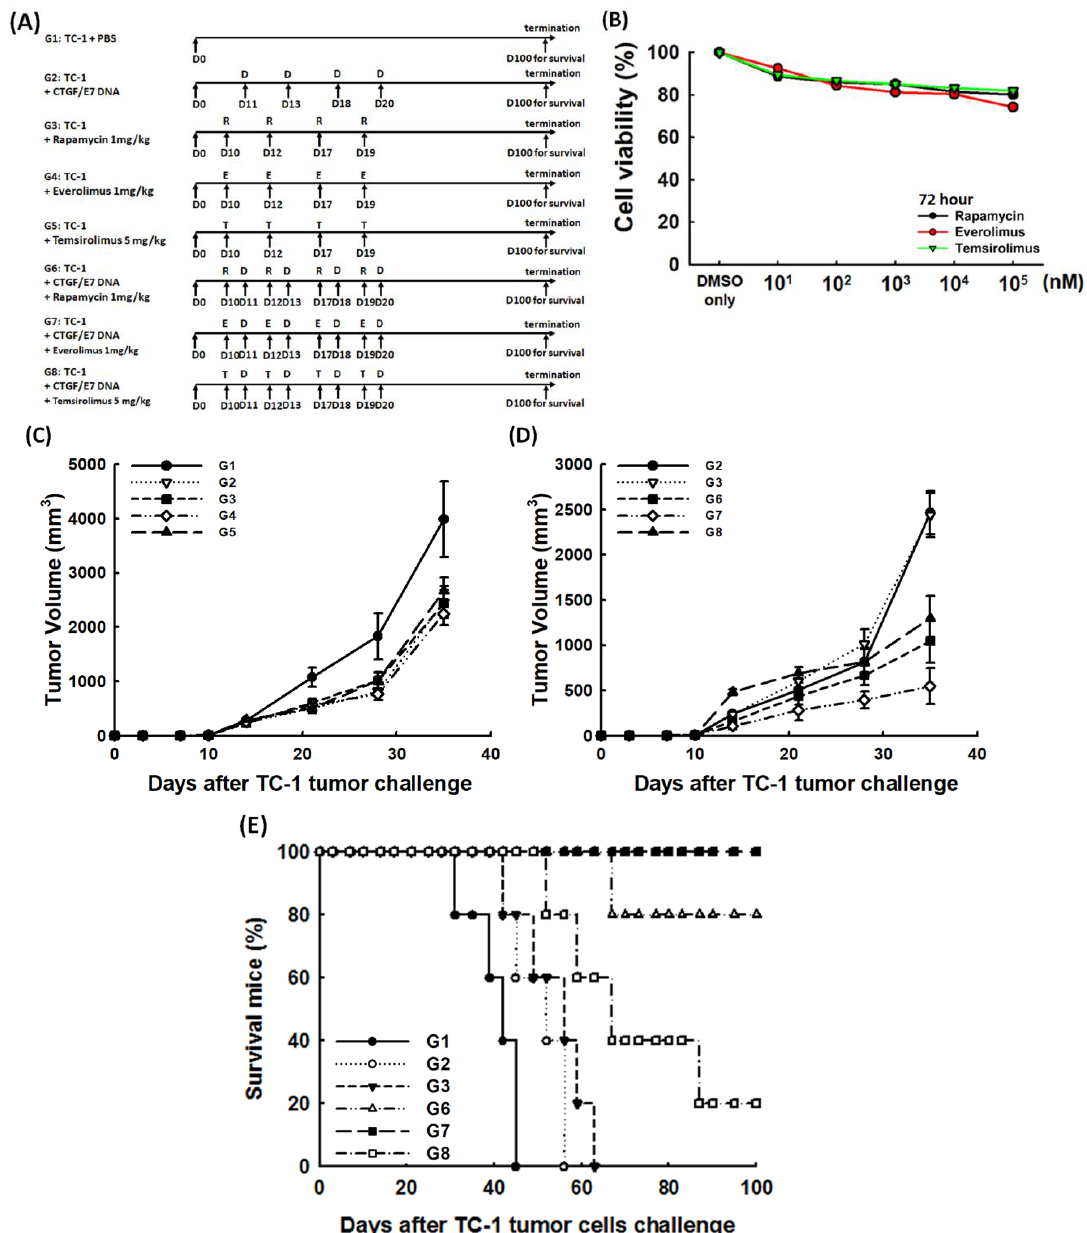
Figure 7. Cont Figure 7 . Cont .